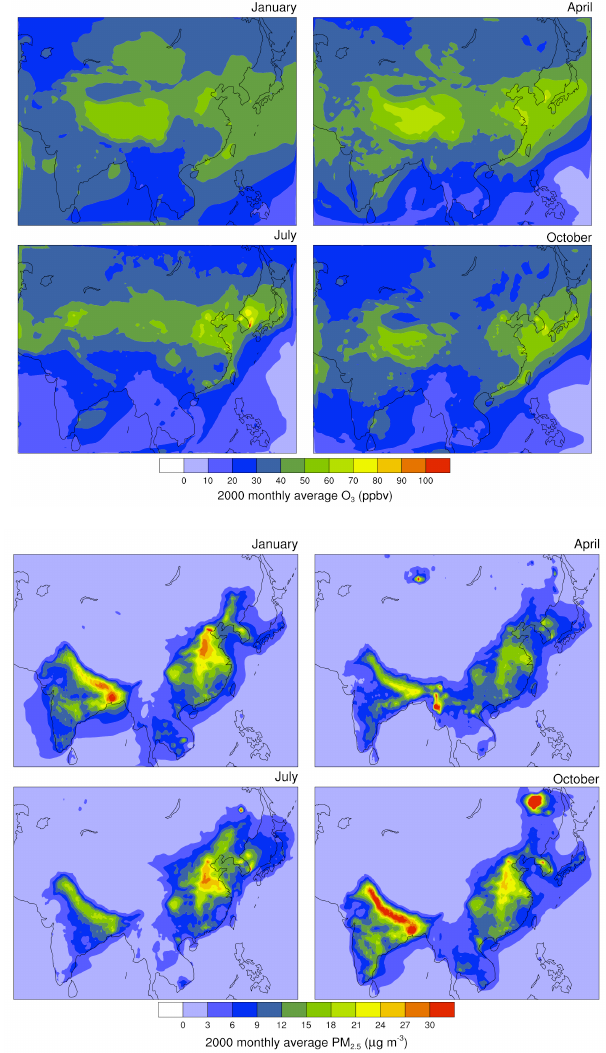
Fig. 7. The monthly mean surface O 3 mixing ratios (ppbv) (top) and PM 2 . 5 concentrations (µgm − 3 ) (bottom) in January, April, July and October, modelled by WRF/Chem for the 2000 baseline.